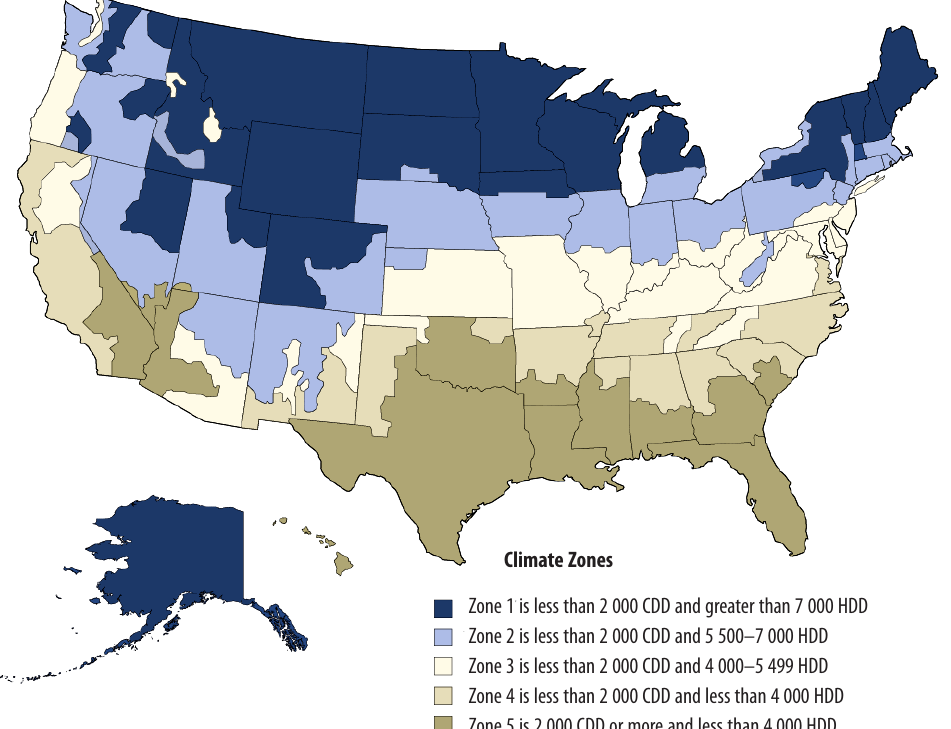
Fig. 2. Climate zones in the United States (EIA 2012)